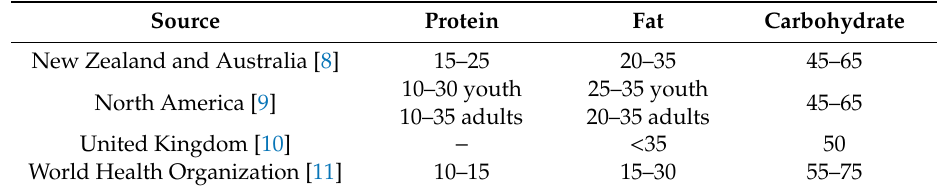
Table 1. Dietary recommendations of % energy contribution to diet based on the prevention of chronic